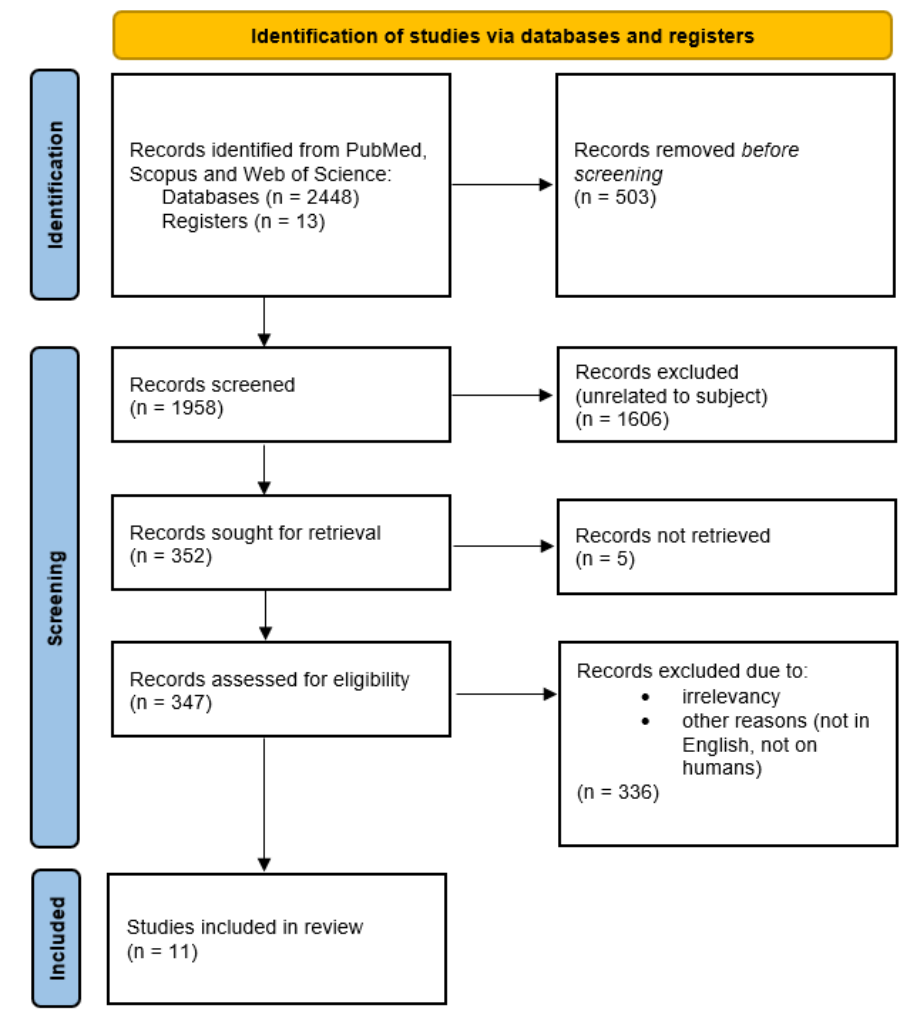
Figure 1. PRISMA diagram for systematic review.